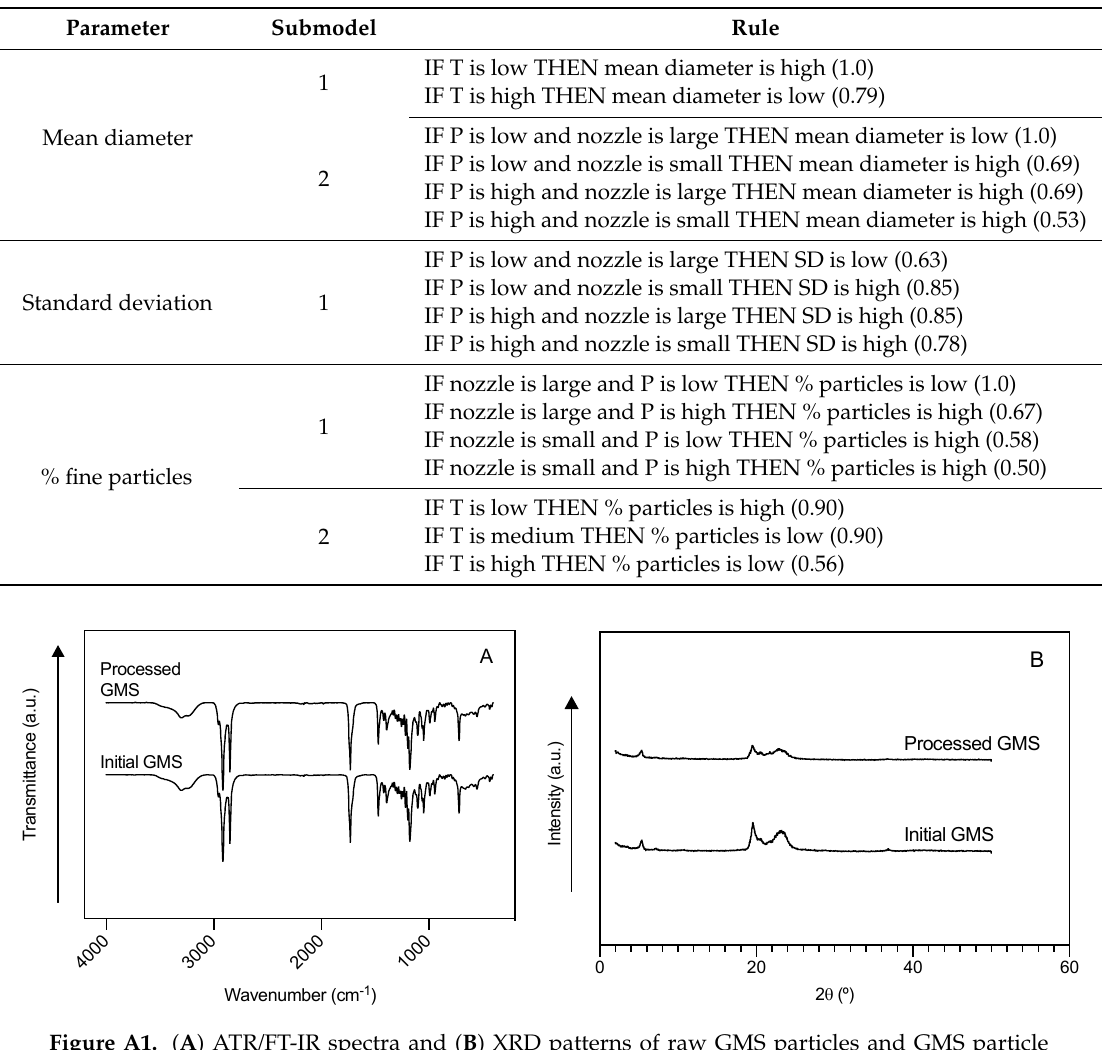
Figure A1. ( A ) ATR / FT-IR spectra and ( B ) XRD patterns of raw GMS particles and GMS particle processed by PGSS ® .